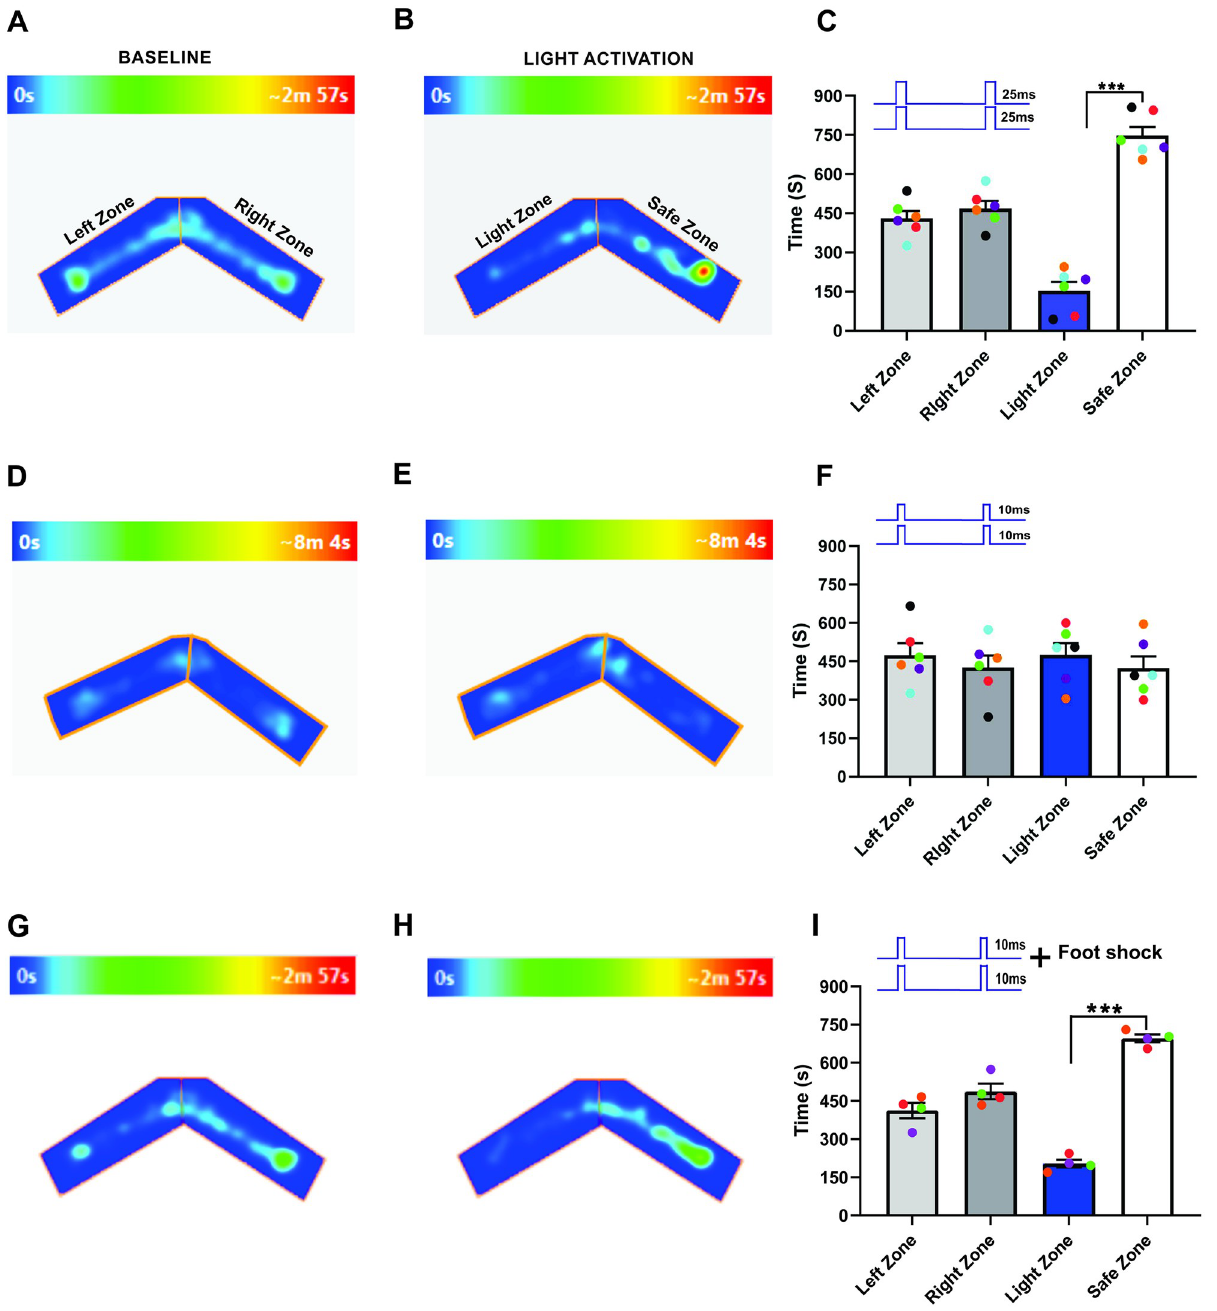
Fig 5. Bilateral olfactory information. A, B, an example of heat-map showing the animal’s position in the “two-arms maze” during baseline (A) and dual OB (25–25 ms) light stimulation (B). C, Average amount of time explored in each zone in baseline and dual OB (25–25 ms) light stimulation trials. D, E, Heat-map of mouse position during baseline (D) and dual OB (10–10 ms) light stimulation (E). F, Average amount of time spent in each zone in baseline and dual OB (10–10 ms) light stimulation trials. ( ��� P0.0003, n = 6 animals). Glomerular activation during shorter duration stimulus. G, H, an example of heat-map showing the animal’s position in the two-arms maze during baseline (G) and 10 ms bilateral light stimulation (H). I, Average amount of time explored in each zone in baseline and 10 ms bilateral light stimulation trials ( ��� P0.0005, n = 4 animals).